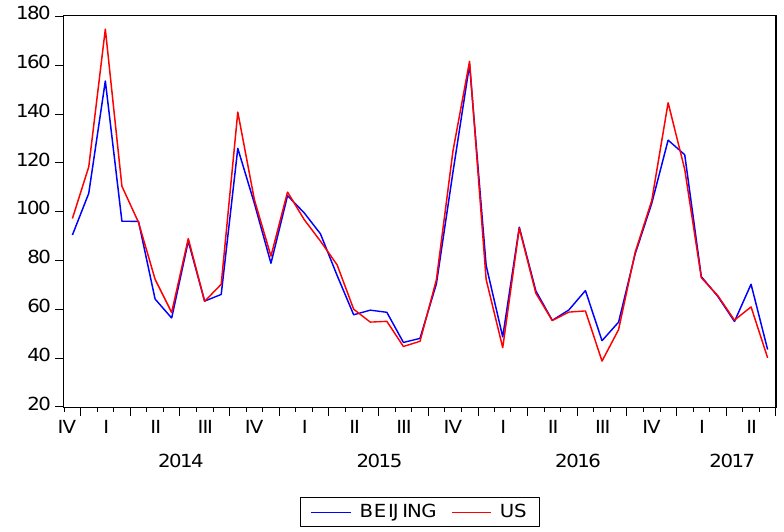
Figure 1. Comparing monthly average PM 2.5 concentrations between US Embassy monitoring data and 35 monitoring stations in Beijing.